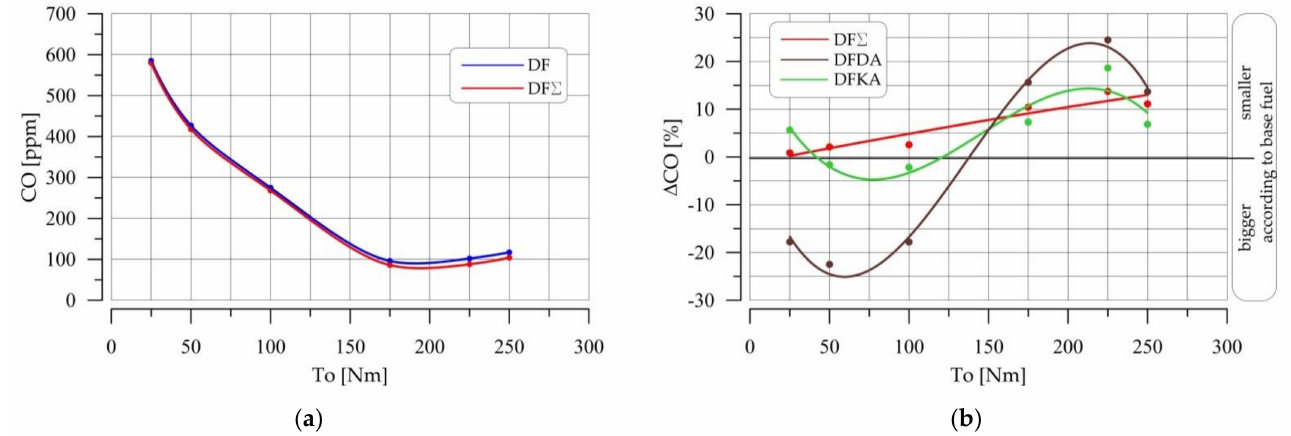
Figure 10. ( a ) CO concentration in the exhaust fumes vs. engine torque; ( b ) Percentage difference in the concentration of CO in the exhaust fumes vs. engine torque in relation to the base fuel.